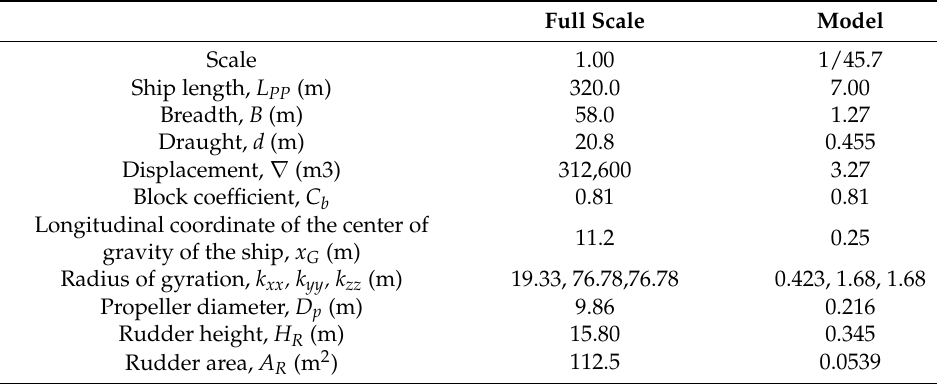
Table 1. Main parameters of the KVLCC2